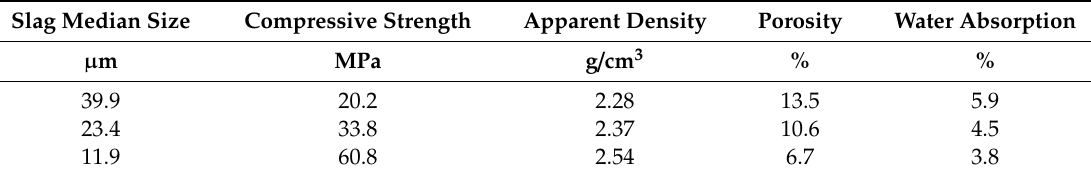
Table 7. Selected properties of AAMs produced under the conditions 12.9 H 2 O / Na 2 O, curing